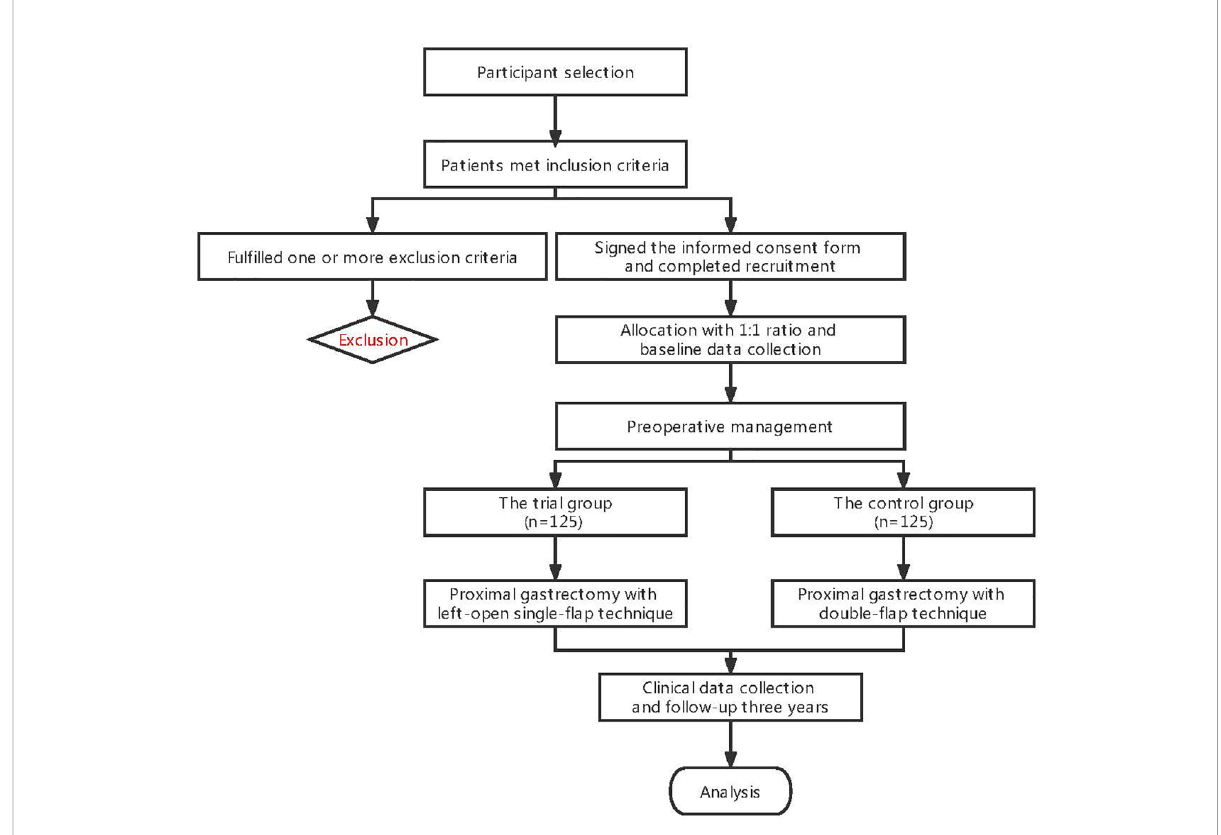
FIGURE 1 Flowchart of the